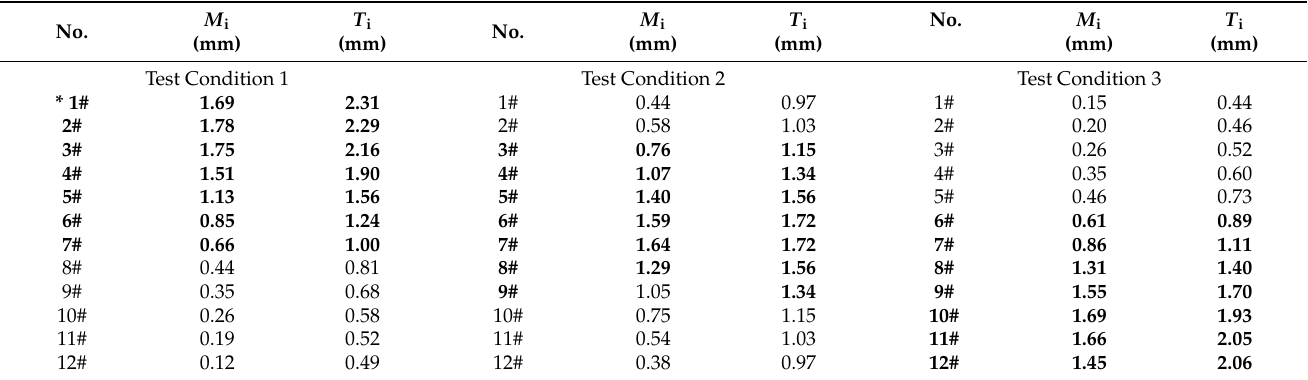
Table 2. Measured deflection ( M i ) and theoretical deflection ( T i ) of Qingling #5